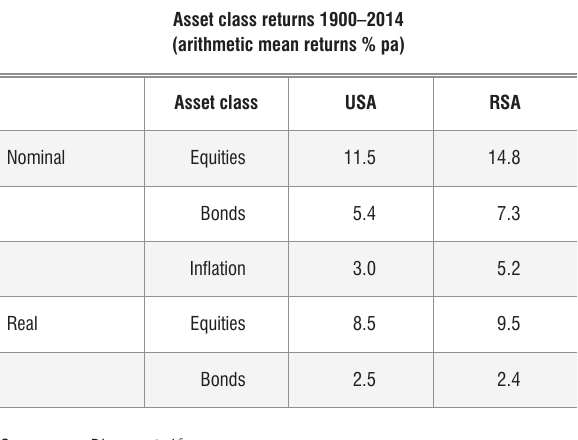
Comparison of US and South African asset class returns